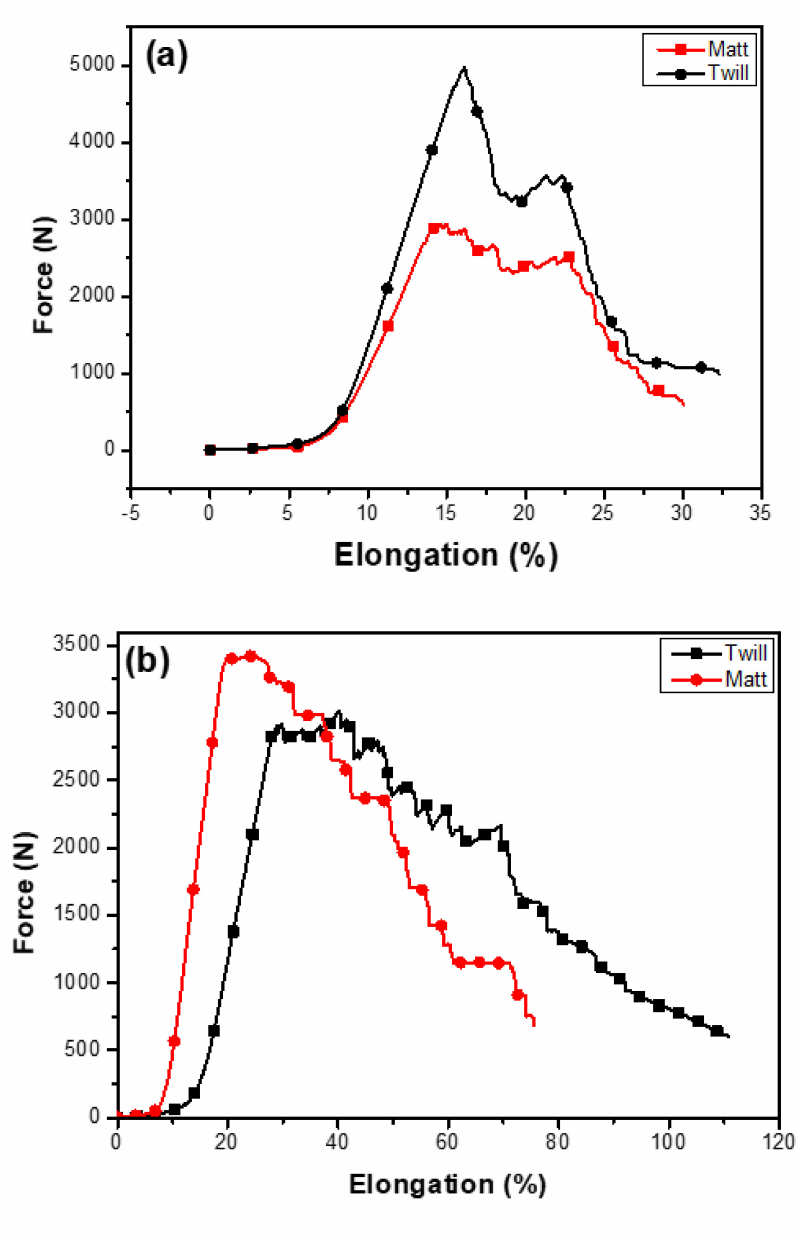
Figure 6. Comparison of tensile properties of matt and twill fabrics ( a ) weft direction and ( b ) warp direction. In AFs, the mutual support of warp and weft yarn makes them shrink and expand alternately, thus in relaxed form of the fabric, the differential shrinkage enables the unit cell of the fabric structure to contract non-uniformly, and the fabric undergoes various levels of shrinkage at different sections resulting in folds formation. When stretched, the unfolding of the folded area starts not only in the stretch direction, but also in the transverse direction, giving rise to the NPR effect. Therefore, the NPR effect results from the interplay between the interlacement pattern of warp and weft in addition to the fabric geometry such as plain, matt or twill, the different stretch properties of the elastic and nonelastic yarns, i.e., the core and the wrap materials, and finally the deformation mechanism of the fabric [10]. Under tensile loading, the axial part of the unit cell tends to expand the lateral portion, resulting in the lateral expansion of initial small-width portion, and increase in its width as well, thus an overall lateral expansion of the fabric occurs. During this process, the warp yarns supply the required support for the opening and reorienting of the yarns in the weft